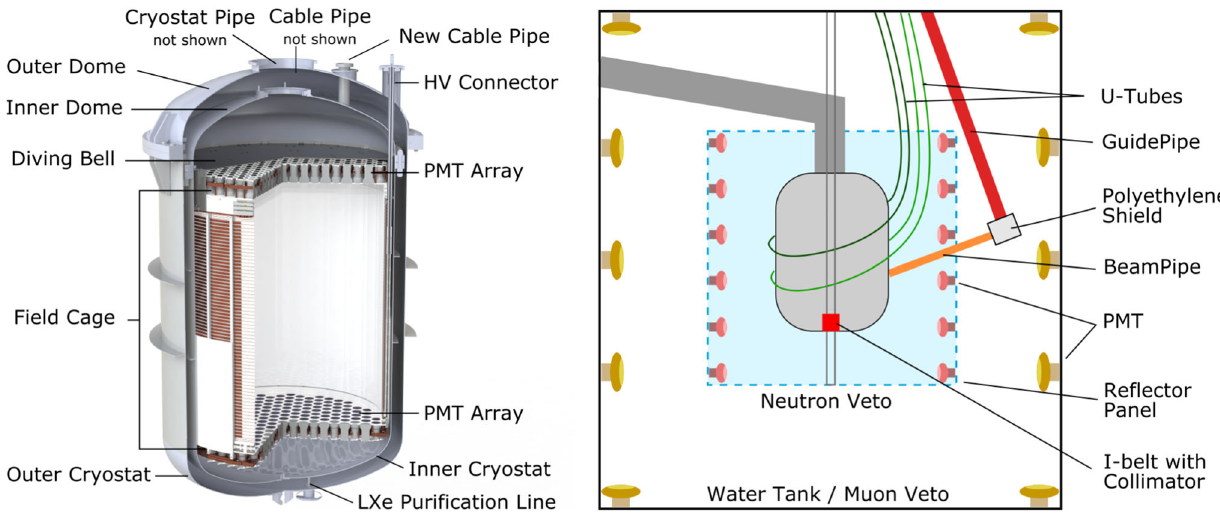
Fig. 1 (left) Render of the XENONnT cryostat and TPC, including the most relevant components investigated during the screening campaign. (right) The cryostat is surrounded by the neutron veto and muon veto which serve as shielding for background reduction. The U-Tubes, Guide Pipe, Beam Pipe, and I-belt are part of the calibration subsystem